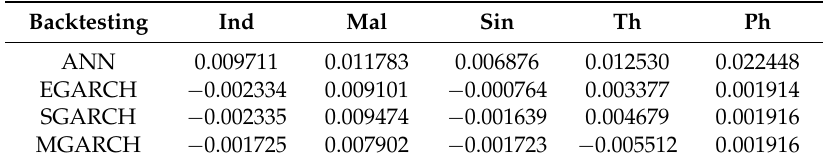
Table A1. Average difference between in sample prediction and out of sample returns.